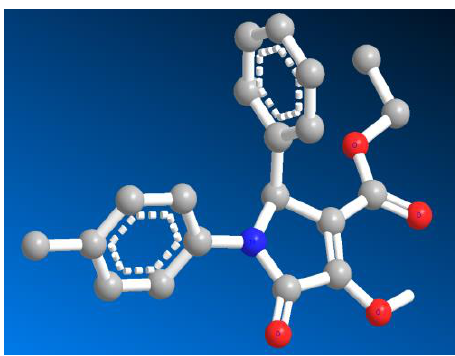
Figure 2. X-ray structure of 11a . (blue ball, Nitrogen; gray ball, Carbon).